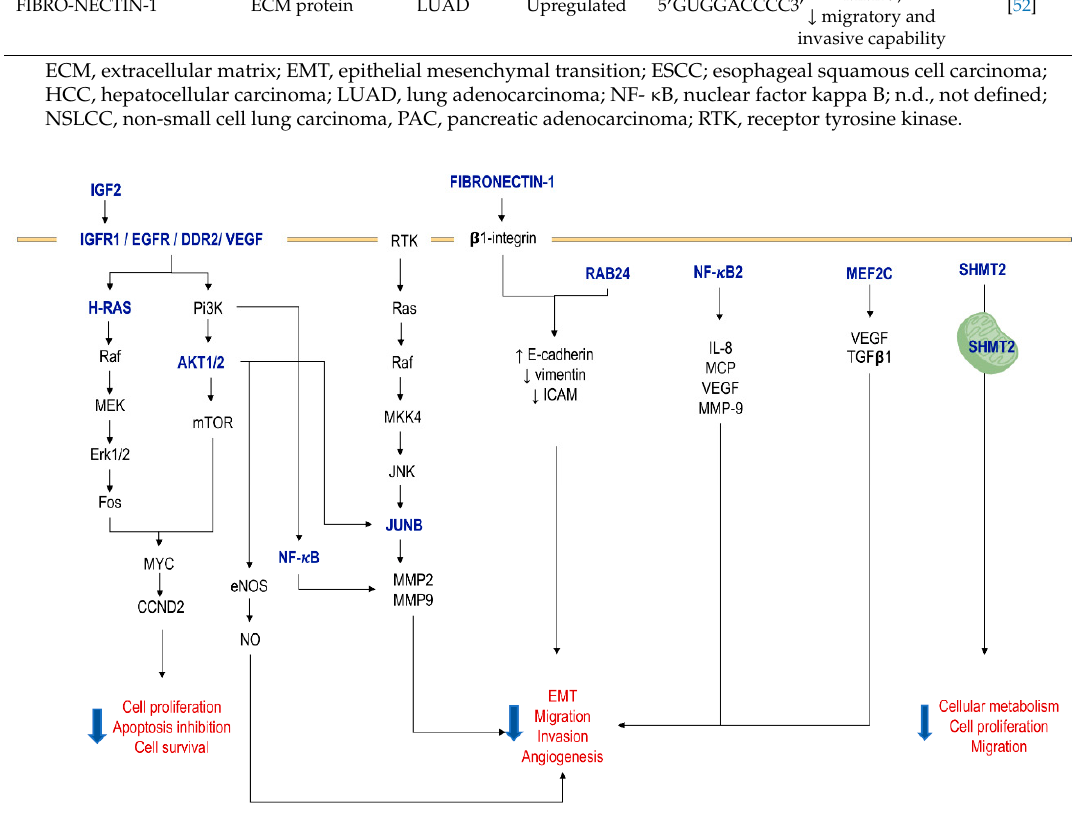
e ff ect of miR-615-5p, promoting cell cycle progression